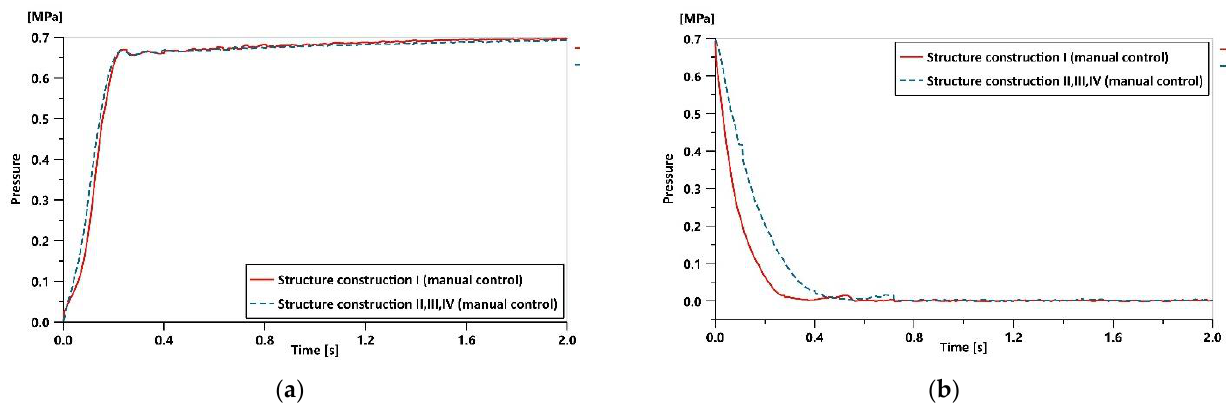
Figure 8. Test results of the pressurization–decompression test under manual control: ( a ) pressurization test and ( b ) decompression test.